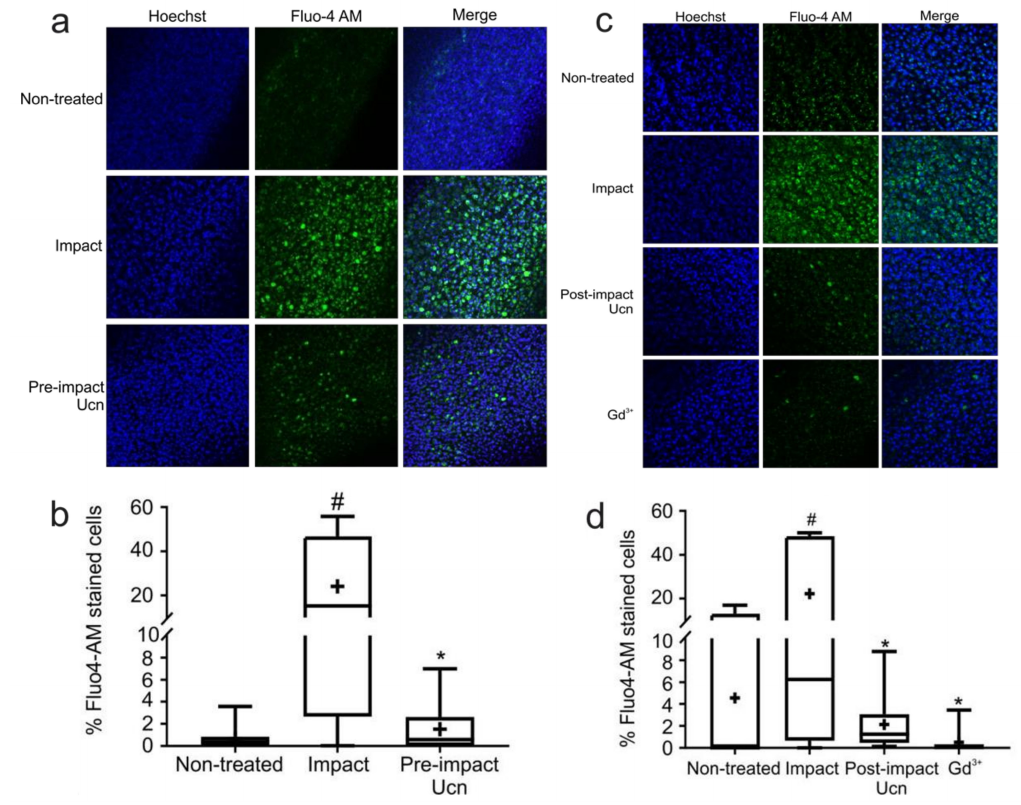
Figure 4. Chondroprotection by Ucn involves the prevention of Ca 2+ overload and blockade of a non-selective cation channel. ( a ) Representative images of explants 1 h post-impact with or without Ucn pre-treatment. Intracellular calcium stained with Fluo-4 AM (green) and nuclei with Hoechst- 33258 (blue). ( b ) Quantification of Fluo-4 AM-stained cells from experiments shown in ( a ) ( n = 6 explants, 5 fields of view/explant; # = p < 0.05 vs. non-treated, * = p < 0.01 vs. impact). ( c ) Representa- tive images of explants 1 h post-impact with or without Ucn or Gd 3+ treatment. Intracellular calcium stained with Fluo-4 AM (green) and nuclei with Hoechst-33258 (blue). ( d ) Quantification of Fluo-4 AM-stained cells from experiments shown in ( c ) ( n = 6 explants, 5 fields of view/explant; # = p < 0.05 vs. non-treated, * = p < 0.01 vs.